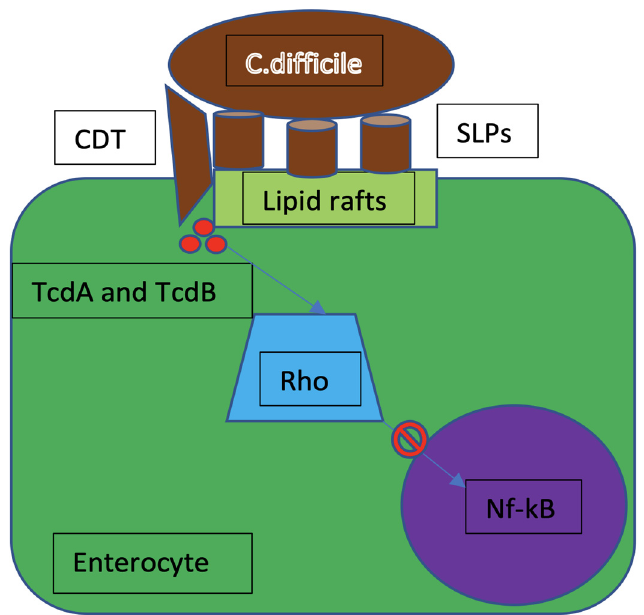
Figure 1. C. difficile mechanism of infection. CDT = C. difficile transferase; SLPs = surface layer proteins; TcdA = C. difficile toxin A; TcdB = C. difficile toxin B; Rho = rhesus homologous; Nf-kB = nuclear factor-kB.